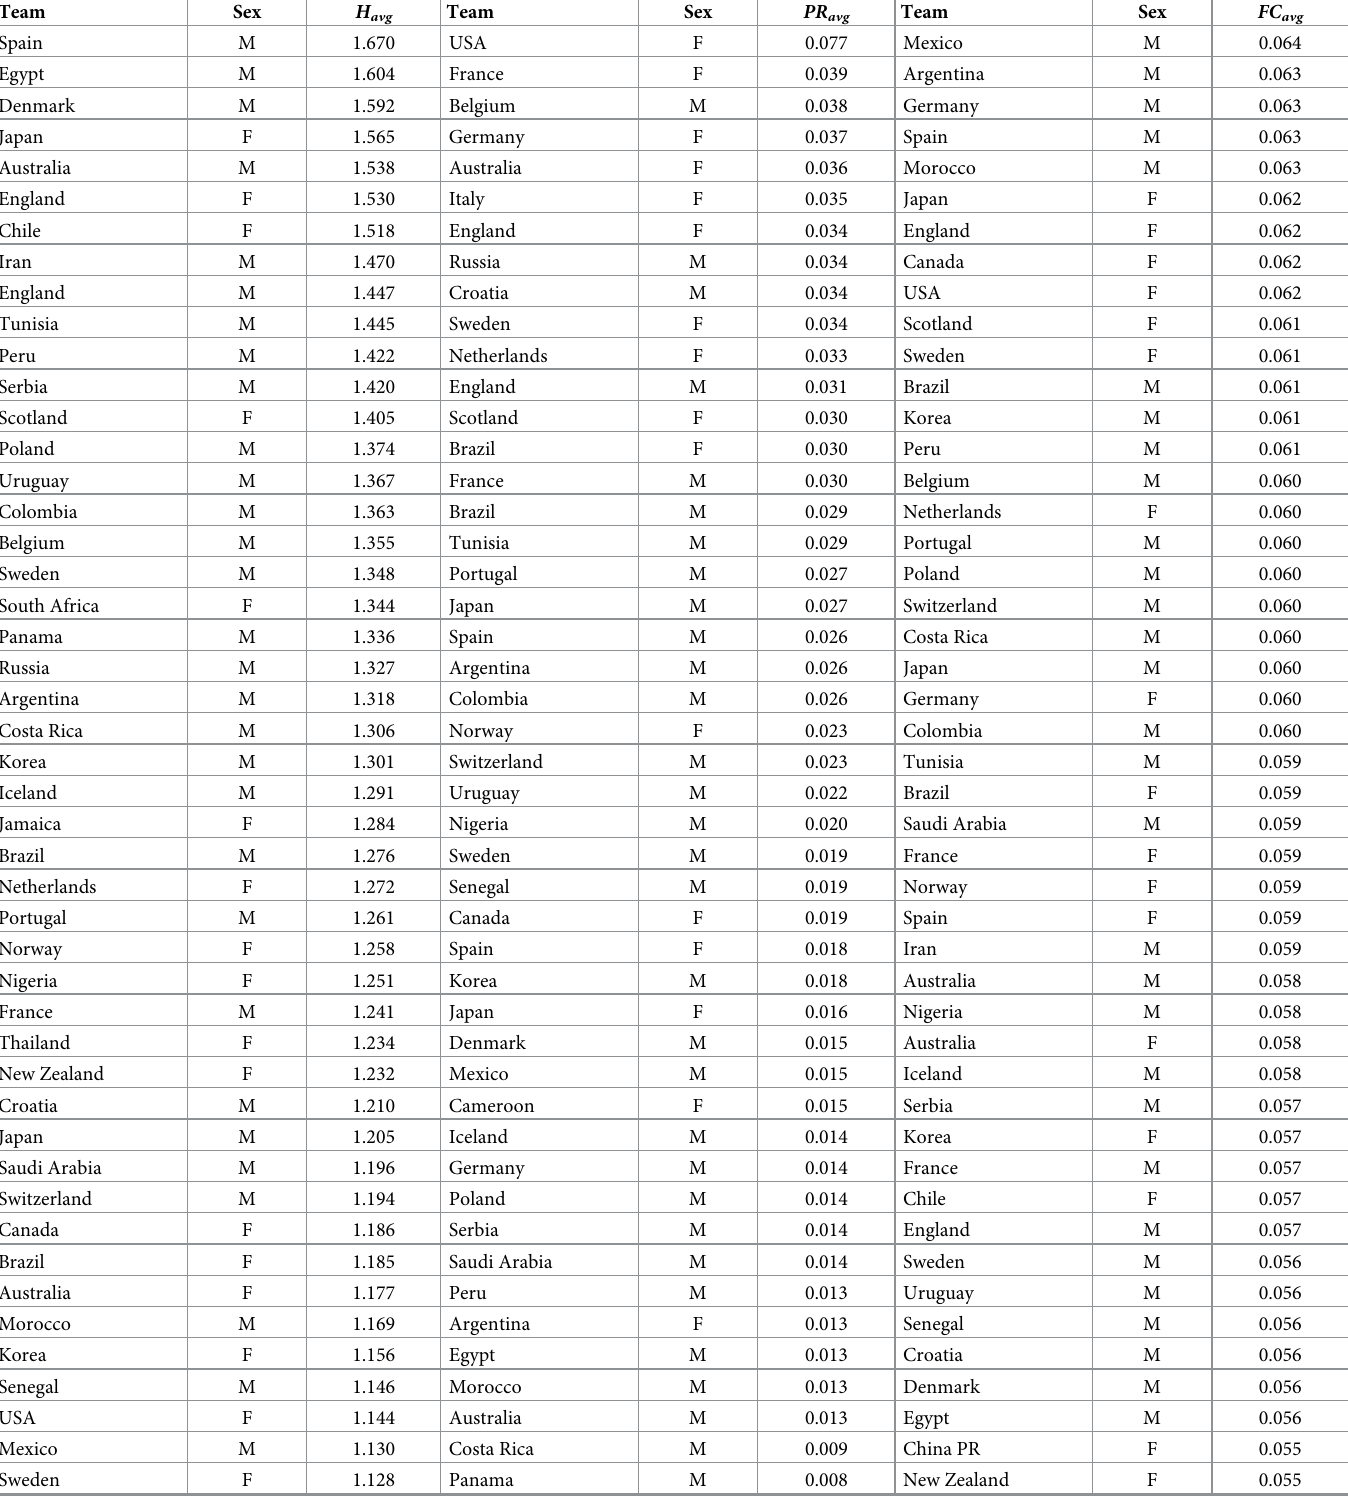
Table 3. Average H indicator, FC, and PR score for each team in the two competitions.